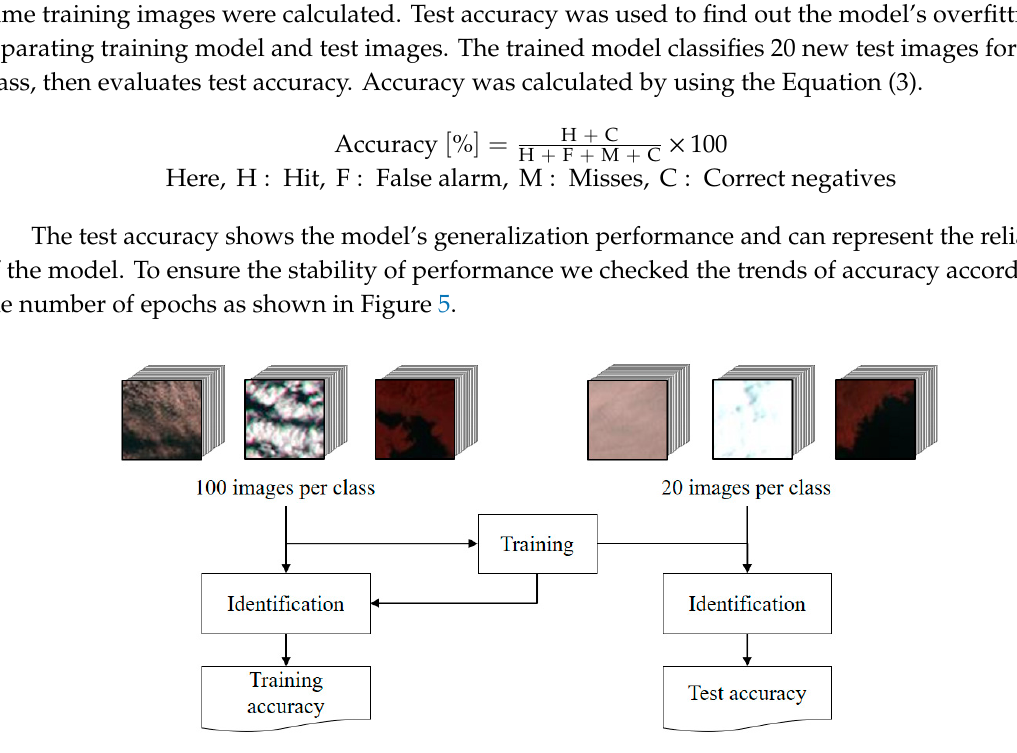
Figure 5. Accuracy of training and test for CNN and CNN-TL with 3-bands images. Black squares and red circles represent training accuracy and test accuracy, respectively: ( a ) VGG19 has high and stable accuracy for both training and test; ( b ) TL enhances its performance from the beginning of VGG19; ( c ) ResNet50 shows lower values because the model was not trained enough; ( d ) TL remarkably increases the accuracy of ResNet50.